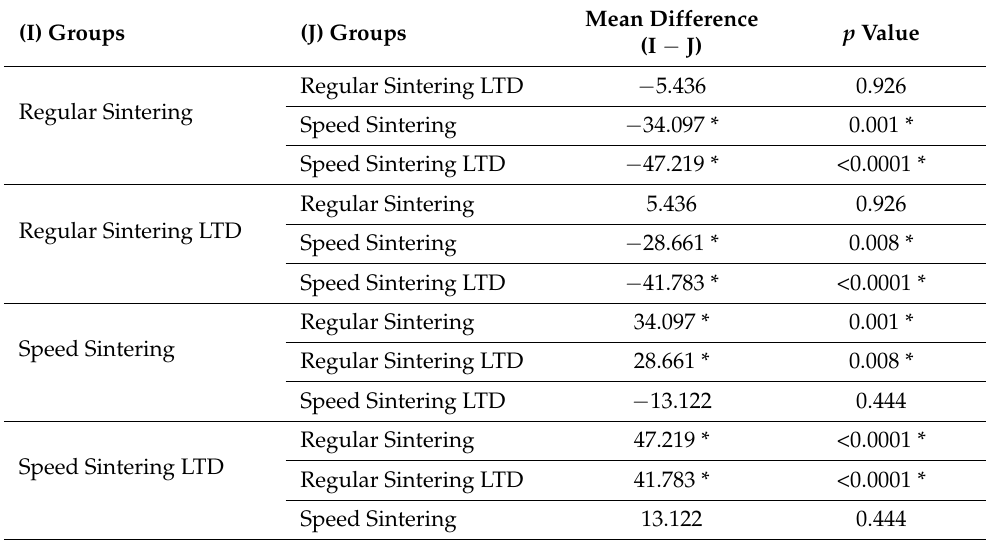
Table 5. Multiple comparisons of the biaxial flexural strength of the zirconia specimens among various